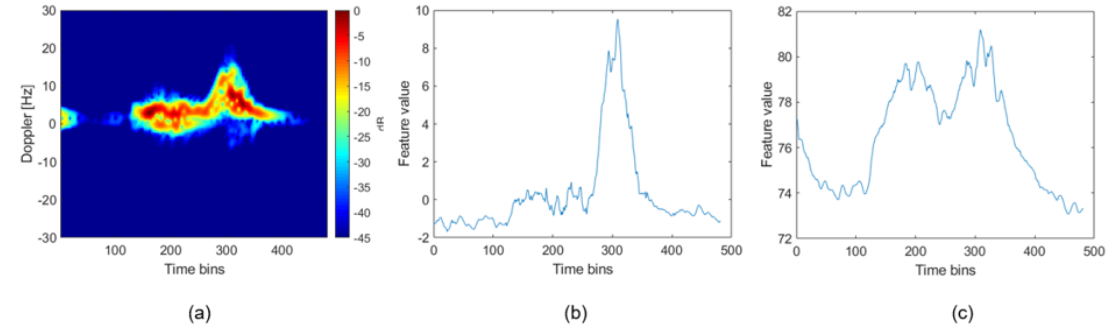
( a ) micro-Doppler spectrogram of sitting activity and its, ( b ) centroid features, ( c ) bandwidth